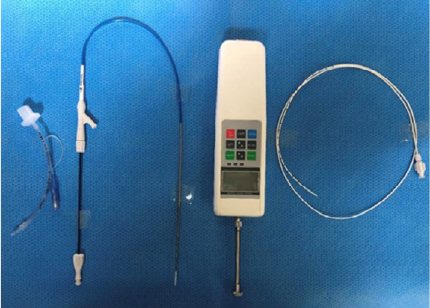
Figure 2 - Equipment used for tracheal stenting in this study. From left to right: a 3-0 endotracheal tube, a self-expanding stent in the delivery system (S-type stent with a wire diameter of 0.006 inches, a D-type stent with a wire diameter of 0.006 inches,